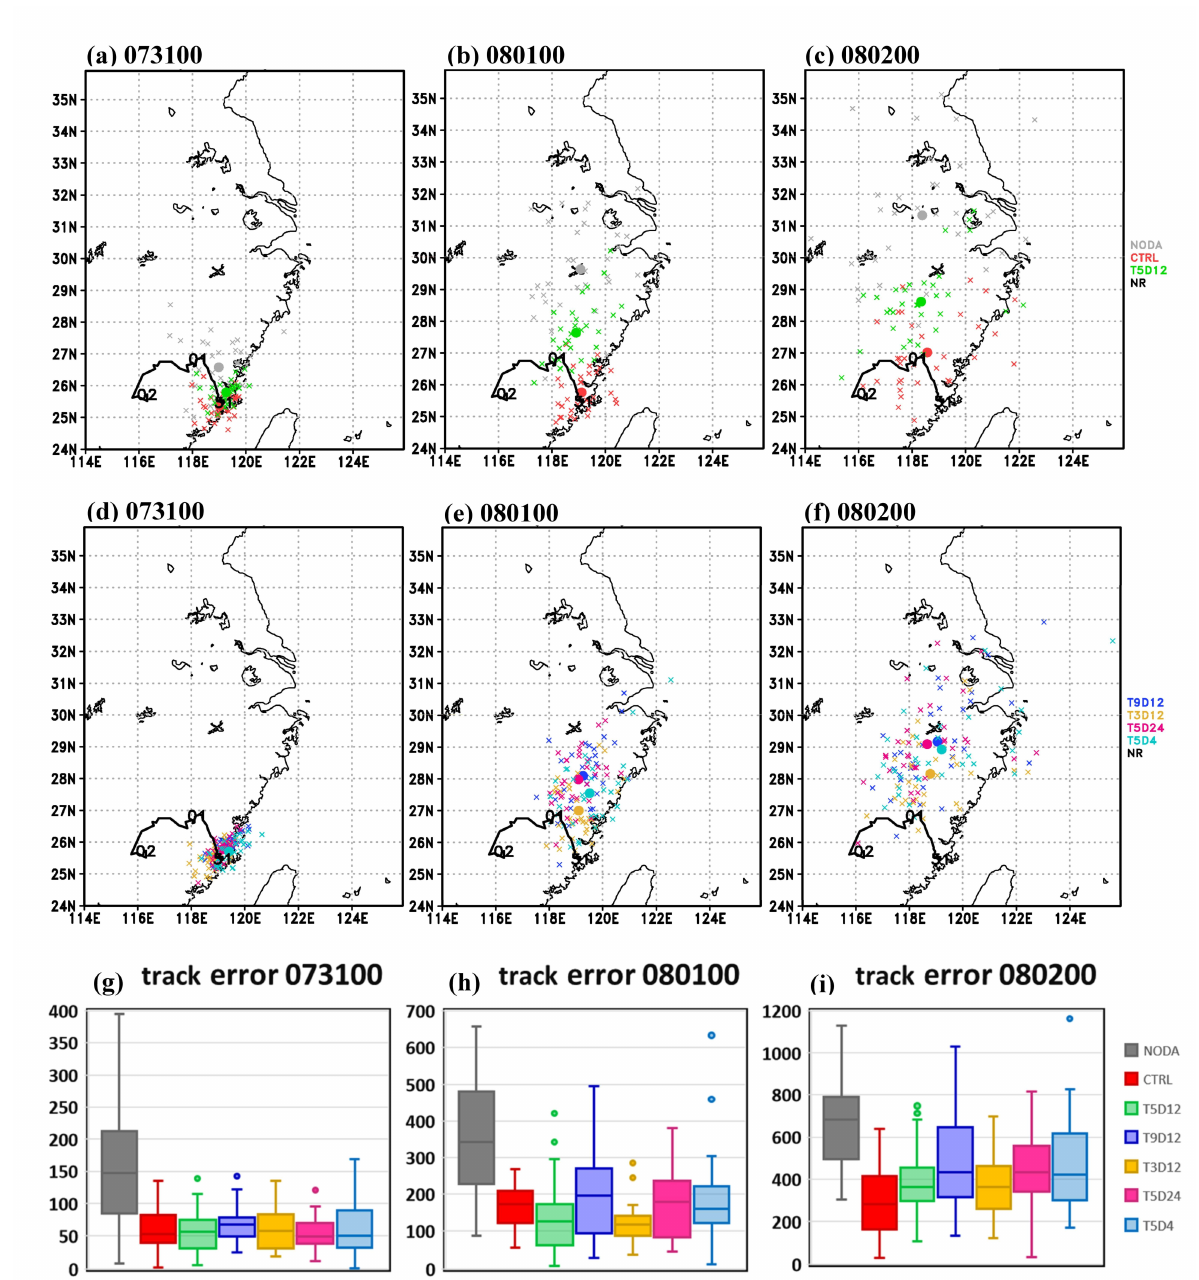
Figure 9. TC locations (crosses) of all 32 ensemble members in NODA (gray), CTRL (red), and T5D12 (green) at ( a ) 0000 UTC 31 July, ( b ) 0000 UTC 1 August, and ( c ) 0000 UTC 2 August. Dots are the ensemble mean locations. The TC track of NR from 0000 UTC 31 July to 0000 UTC 2 August is shown in black curves, with the dates denoted by numbers. ( d – f ) Same as ( a – c ) but for T9D12 (blue), T3D12 (yellow), T5D24 (magenta), and T5D4 (cyan). Box plots of the track errors at ( g ) 0000 UTC 31 July, ( h ) 0000 UTC 1 August, and ( i ) 0000 UTC 2 August were computed using the TC locations of NR as the truth. The box extends from the first quartile to the third quartile (interquartile range), with a line denoting the median value. The upper/lower error bars show the data value that is 1.5 × the interquartile range above/below the third/first quartile. The dots are